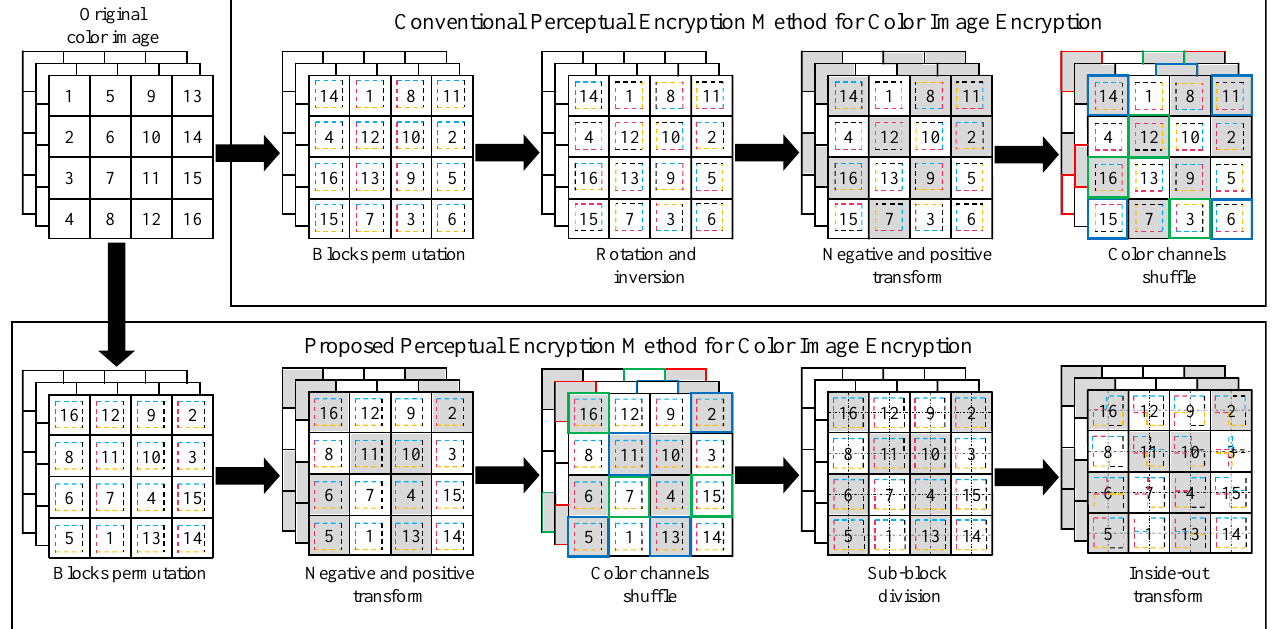
Figure 1. Block-based perceptual encryption algorithms. ( a ) The conventional perceptual encryption scheme. ( b ) The proposed inter and intra block processing-based perceptual encryption scheme.